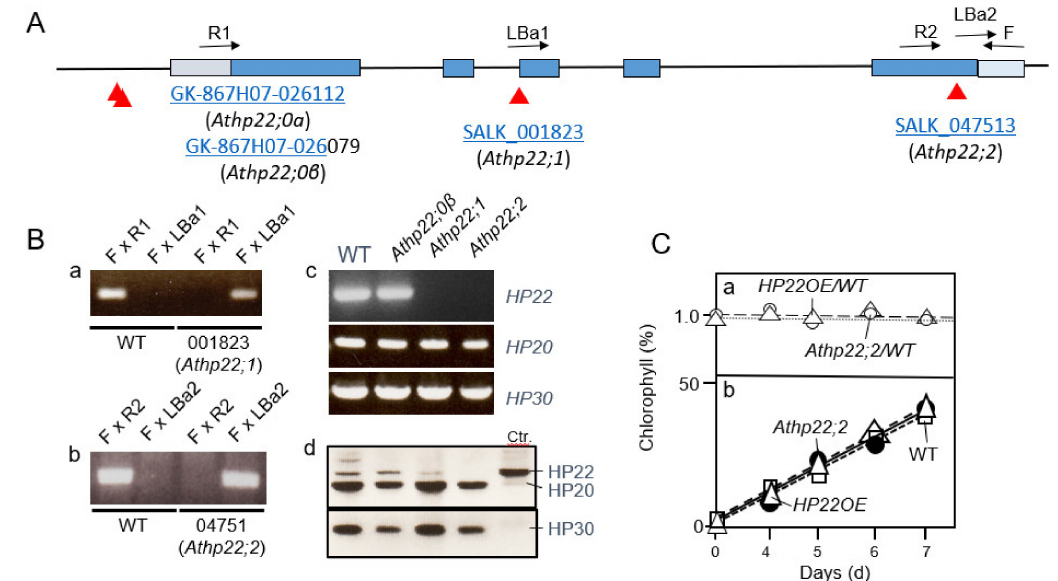
Figure 4. Identification of Athp22;1 (SALK_001823) and Athp22;2 (SALK_047513) mutants. ( A ) Structure of the AtHP22 gene (At5g55510) and positions of T-DNA insertions. ( B ) Genotyping to identify homozygous Athp22;1 (SALK_001823)(a) and Athp22;2 (SALK_047513)(b) plants, and demonstration of the absence of HP22 transcript by RT-PCR (c) and HP22 protein by Western blotting using antibodies against HP22 and HP20 (d). Respective PCR and Western blot data for the chosen controls are included (c and d). What does the Ctr in panel B, d stand for? ( C ) Chlorophyll accumulation in 4.5 days-old, dark-grown Athp22;2 (SALK_047513) mutant and wild-type (WT) seedlings as well as wild-type seedling overexpressing the HP22 cDNA after white light exposure (in hours). The lower panel (b) shows the kinetics of chlorophyll accumulation, whereas the upper panel (a) shows the same data relative to those seen for the wild-type. Because all values are close to 1, there are no differences in the kinetics of chlorophyll accumulation detectable for Athp22;2 (SALK_047513) mutant (open circles and dots) and HP22-overexpressing plants (open and filled triangles) versus wild-type plants